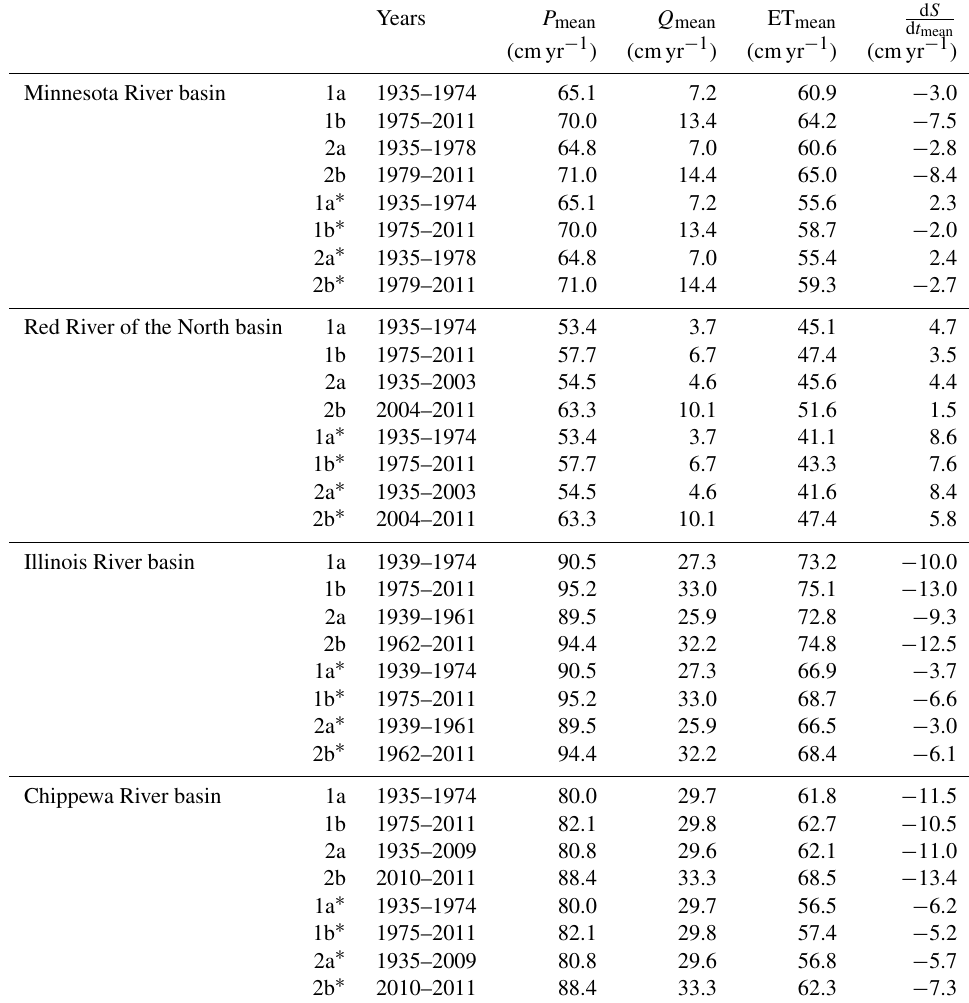
Table 4. Observed average annual precipitation ( P ), flow ( Q ), evapotranspiration (ET), and storage during the pre-period (a) and post-period (b) split by 1974/1975 (1) and land cover transition (LCT) (2)